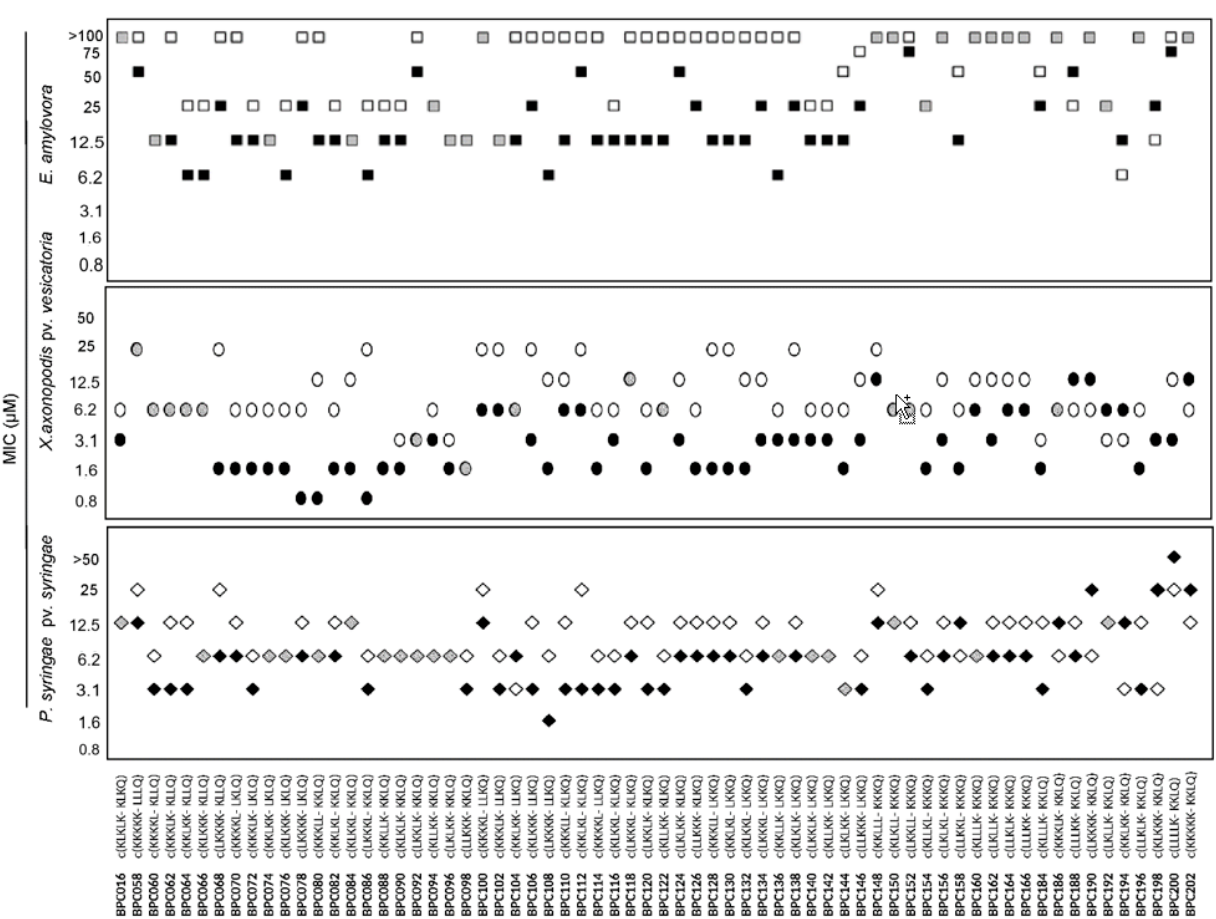
Figure 1. Antibacterial activity of the cyclic peptides incorporating a Trp or a Phe. Sequences and codes of the cyclic peptides are depicted, “-”stands for Trp (W) or Phe (F). Antibacterial activity is given as the minimal concentration that inhibits growth (MIC). The MIC axis is in logarithmic scale and for each sequence the lowest value of the MIC range is represented. Black symbols correspond to peptides with a Trp, white symbols to peptides with a Phe and grey symbols to peptides that exhibit the same MIC values. Data can be found in Table S1 (Supporting Information).